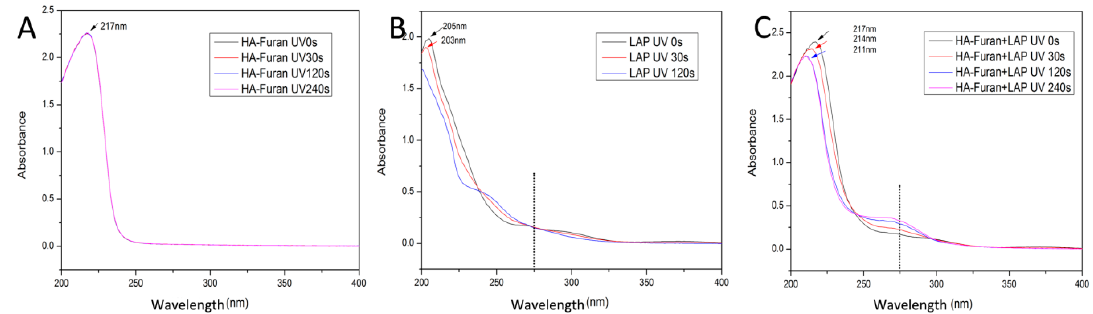
Figure 3. UV-Vis spectrophotometer under different illumination time. ( A ) HA-Furan; ( B ) LAP; ( C ) HA-Furan with LAP.